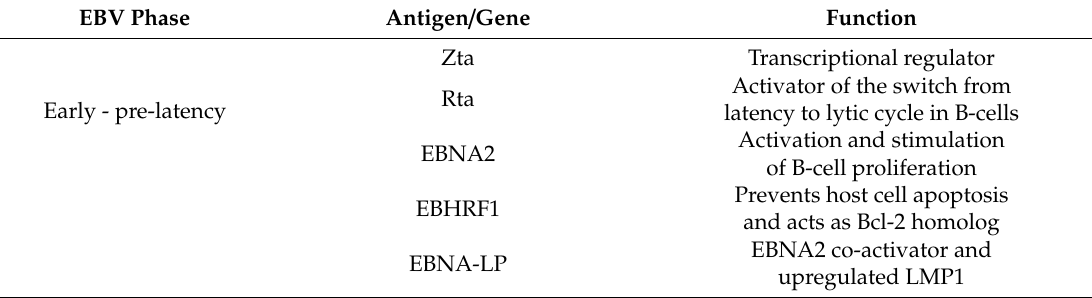
Table 1. EBV-based molecular targets for development of EBV